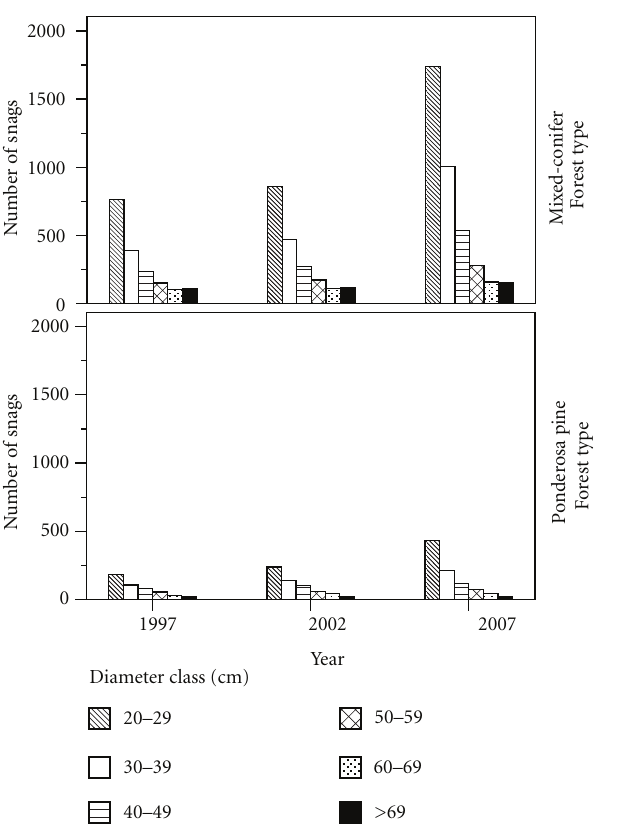
Figure 5: Size-class distribution of snags in northern Arizona mixed-conifer and ponderosa pine forest in 1997, 2002, and 2007. Absolute numbers of snags increased in all size classes in both forest types. In contrast, proportions of snags generally increased in the smaller size classes and decreased in the larger size classes in both forest types.